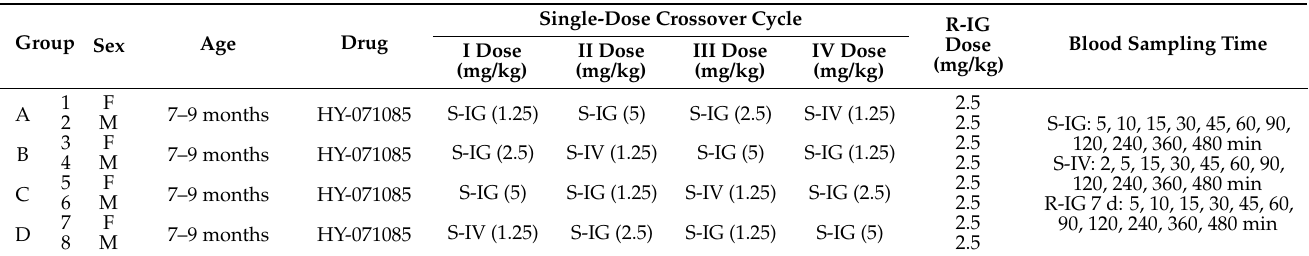
Table 6. The pharmacokinetics study design using beagle